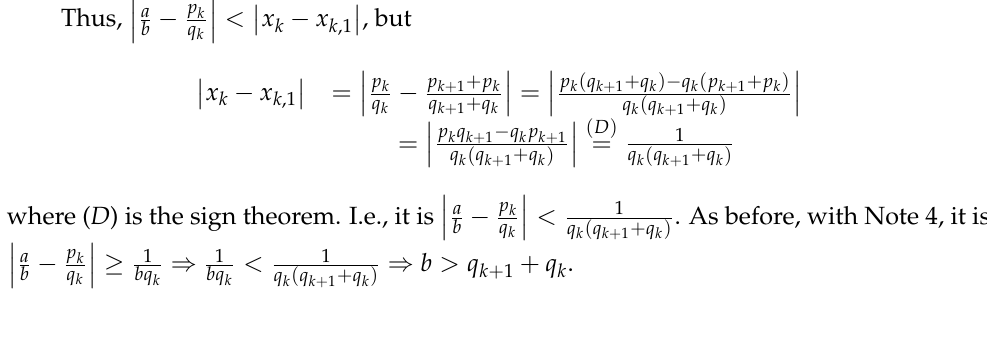
Figure 15. Distances within an interval of convergents ( k even).